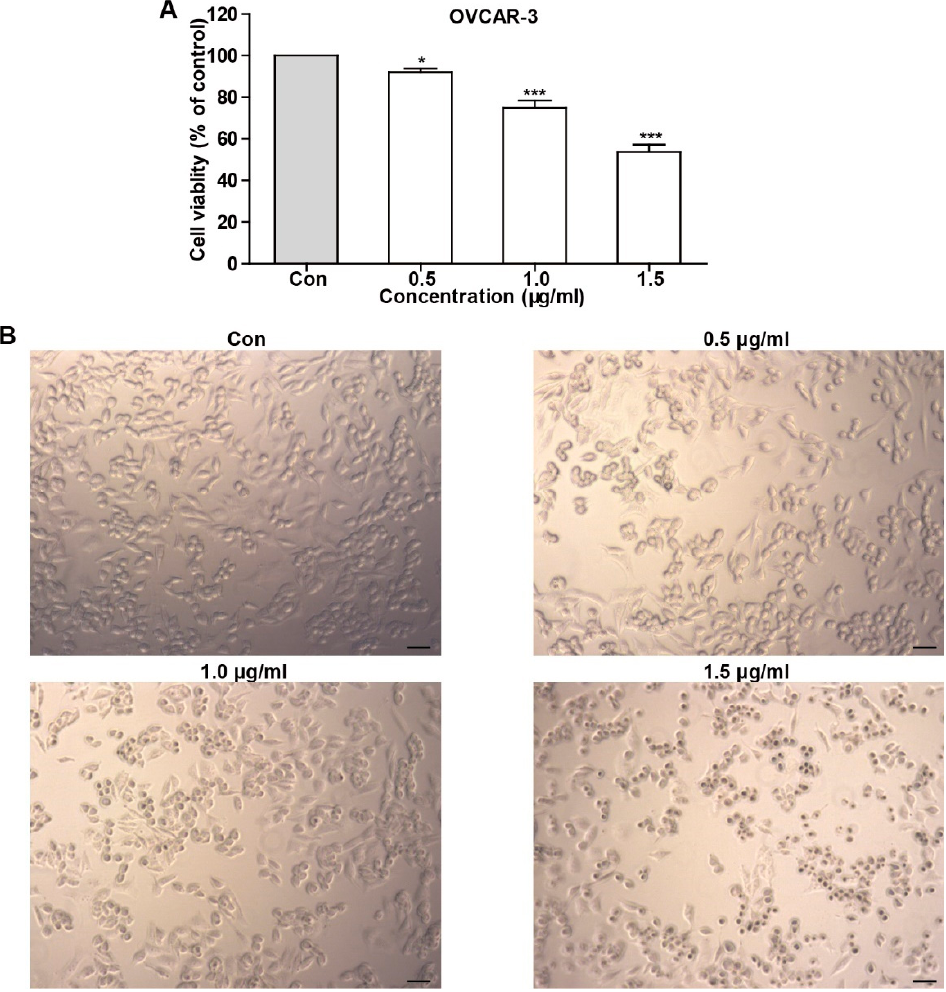
Figure 2. TFS decreased cell viability and induced morphology changes in OVCAR-3 cells. ( A ) The effect of TFS on cell viability was conducted using an MTS assay. Results were obtained from three independent experiments and expressed as mean ± SEM. Significant difference verse control (* p < 0.05 and *** p < 0.001. ( B ) OVCAR-3 cells were treated with the indicated concentrations of TFS for 24 h. Cell morphology was observed using microscopy (magnification 10×), scale bar = 50 μ m.